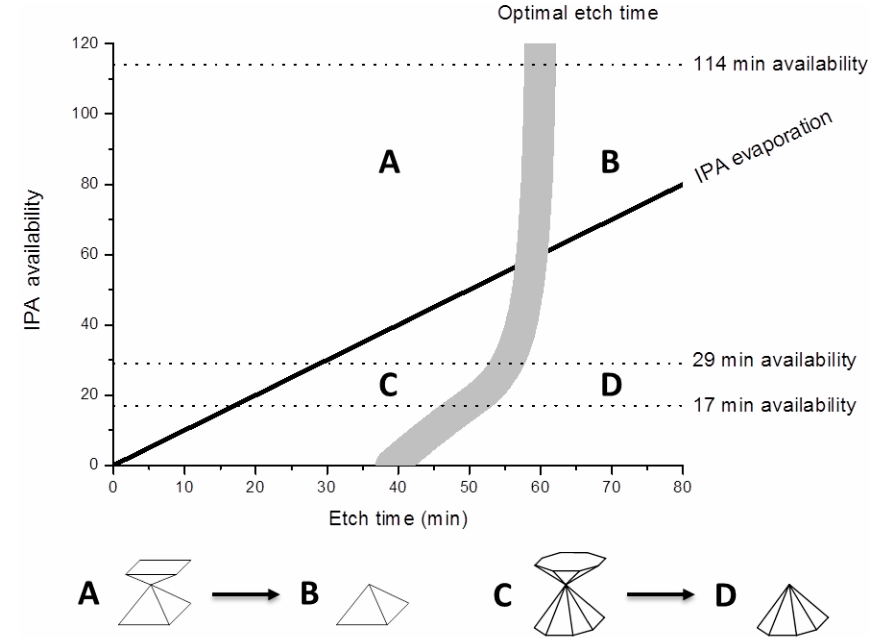
Figure 12. Schematic diagram of the evolution of silicon wet etch structures, under IPA influence, for a 10 μm square mask and the conditions depicted in Table 1.